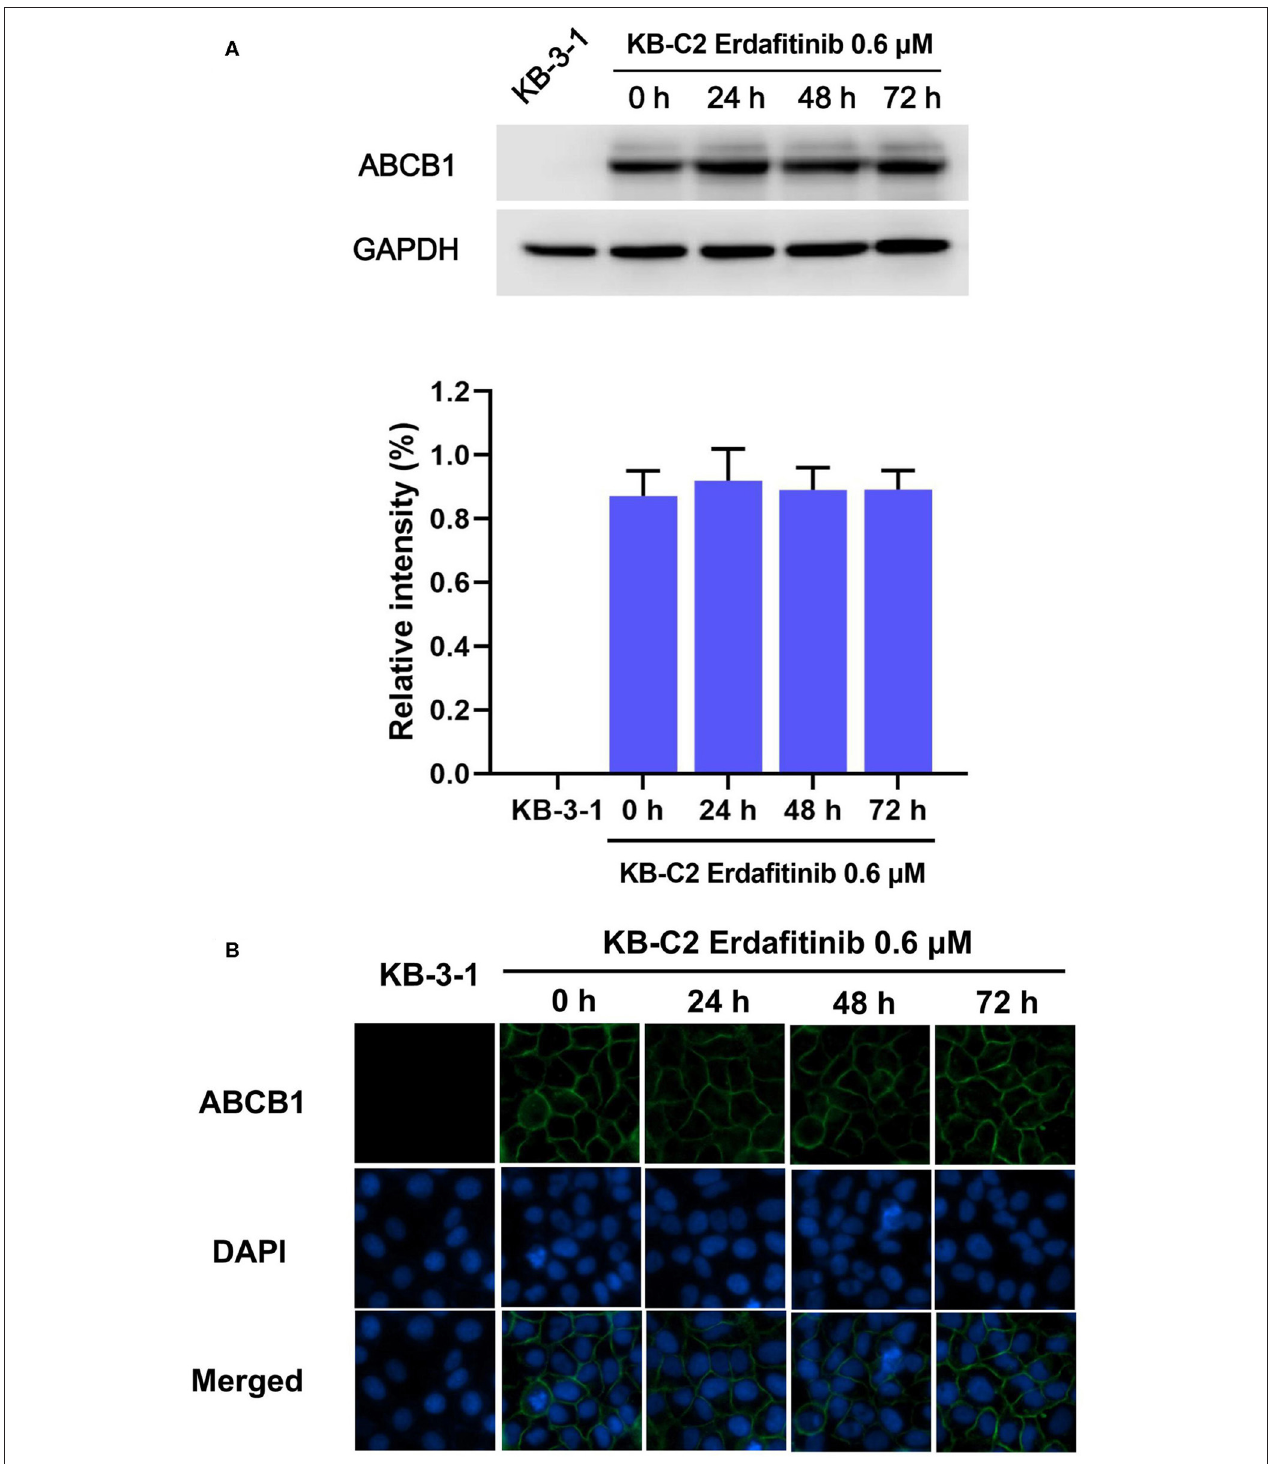
FIGURE 2 | Erdafitinib modified neither the expression nor the cellular localization of ABCB1 in KB-C2 cells. (A) The effect of erdafitinib on ABCB1 expression in KB-C2 cells. (B) The effect of erdafitinib on the cellular localization of ABCB1 in KB-C2 cells. The results are representative of three independent experiments. Error bars indicate SD. Green: ABCB1. Blue: nuclei.